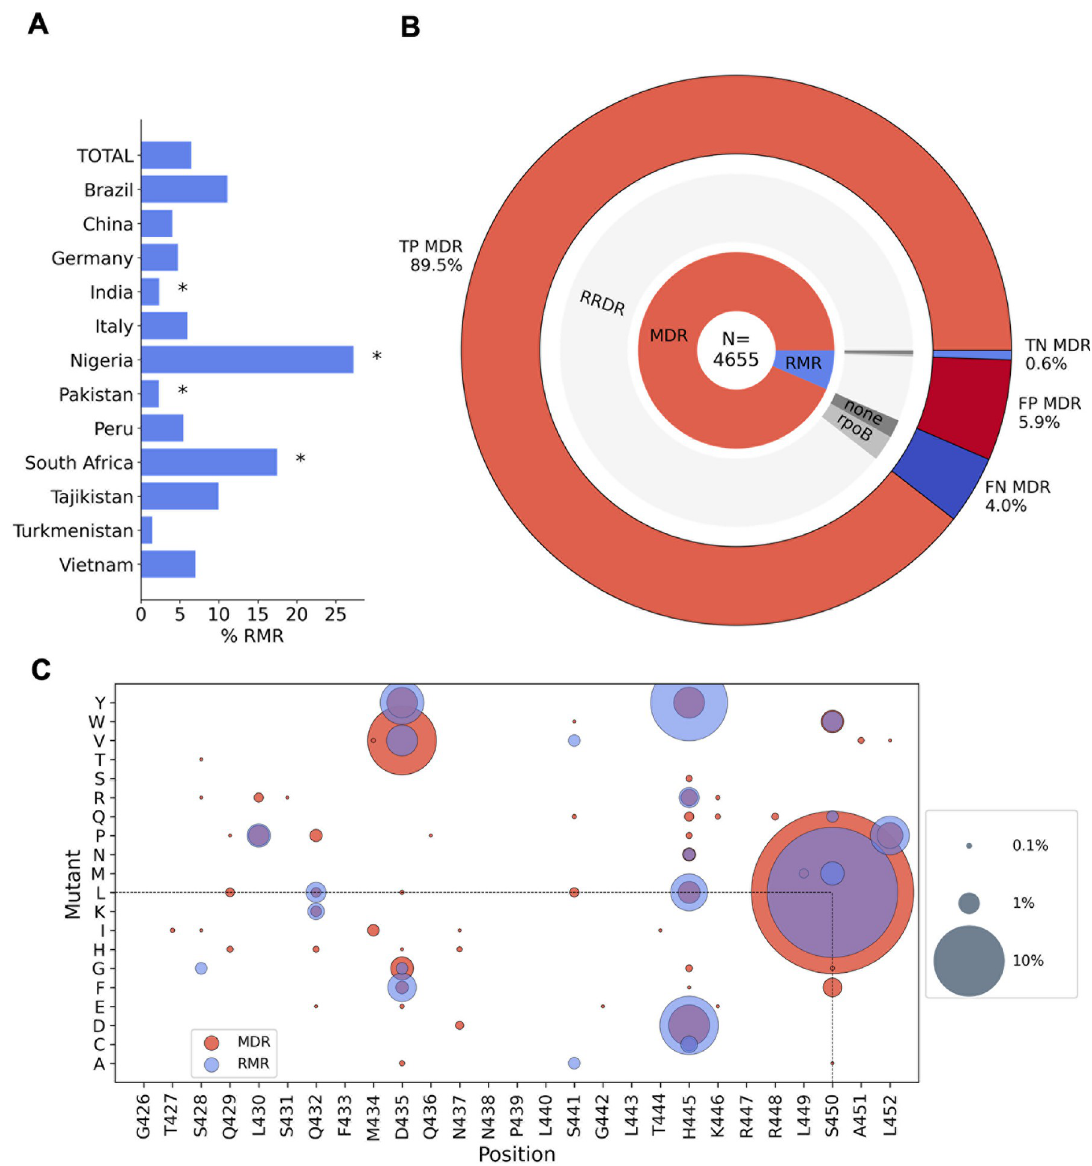
Fig 6. Rifampicin monoresistance. (A) Percentage of RR isolates that are RMR by country of isolate origin. � indicates RMR proportions that were significantly different from that of the total dataset using a 2-tailed z-test with 95% confidence. (B) MDR predictions for RR isolates made using the Xpert MTB/RIF assay proxy. N is the total number of RR isolates. The inner ring shows the proportion of RR isolates that are RMR and MDR. The middle ring represents the proportions of RMR and MDR isolates that have an SNP (synonymous or nonsynonymous) in the RRDR of rpoB (“RRDR”), no RRDR SNP but a SNP elsewhere in the rpoB gene (“ rpoB ”), and no rpoB mutations (“none”). The outer ring shows the expected TP, TN, FP, and FN MDR predictions of Xpert MTB/RIF assay, based on the SNPs present in the RR isolates. (C) Nonsynonymous mutations found in the RRDR of rpoB in RMR isolates and MDR isolates. Presence of a coloured spot indicates that the mutation was found in RMR/MDR isolates, and spot size corresponds to the proportion of RMR or MDR isolates carrying that mutation. FN, false negative; FP, false positive; MDR, multidrug resistant; RRDR, rifampicin resistance–determining region; RMR, rifampicin monoresistant; RR, rifampicin resistant; SNP, single nucleotide polymorphism; TN, true negative; TP, true